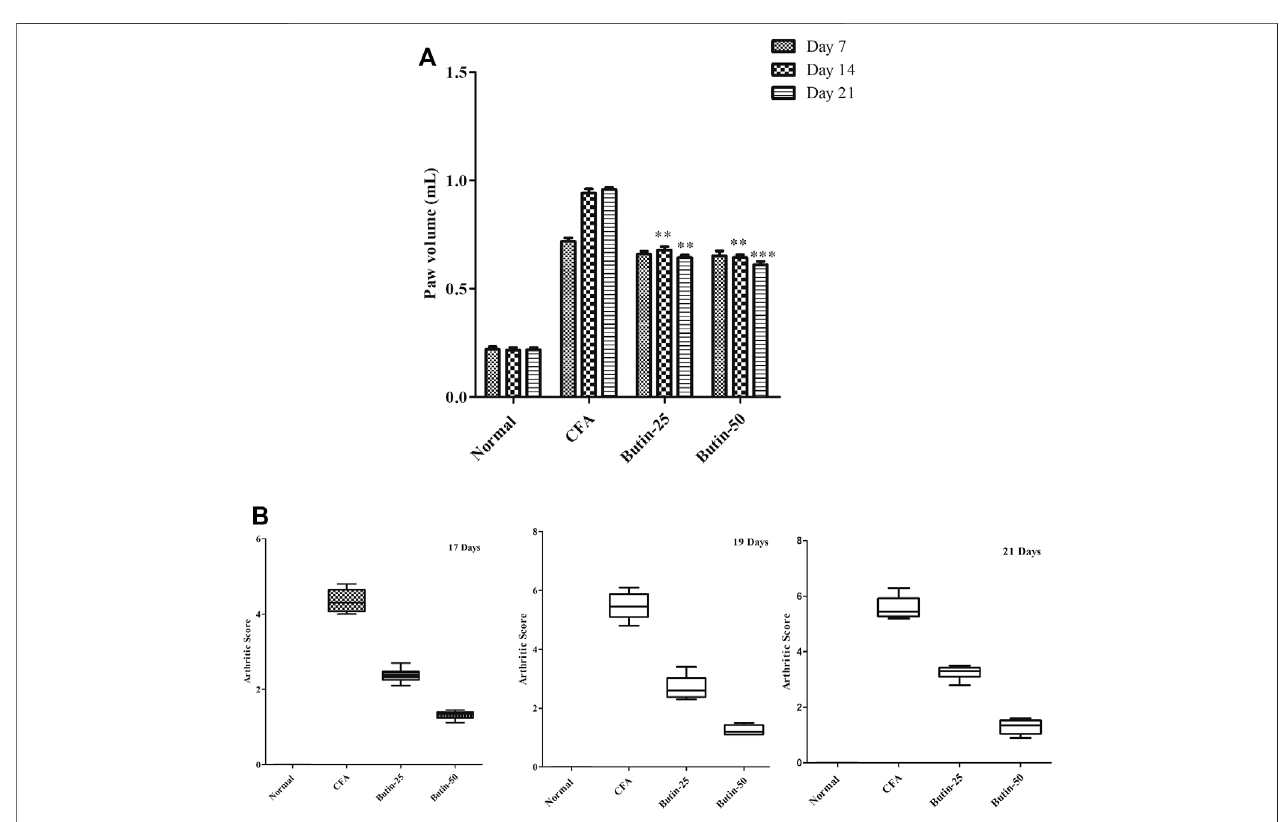
FIGURE 3 | Effect of butin on (A) the paw volume and (B) arthritis severity score in CFA-treated rats. Values are expressed in mean ± SEM ( n = 6). # p < 0.05 vs. normal control rats and ** p < 0.01 and *** p < 0.001 vs CFA control rats. Two-way ANOVA followed by the Bonferroni post hoc test for paw volume and Kruskal – Wallis test for the arthritis severity